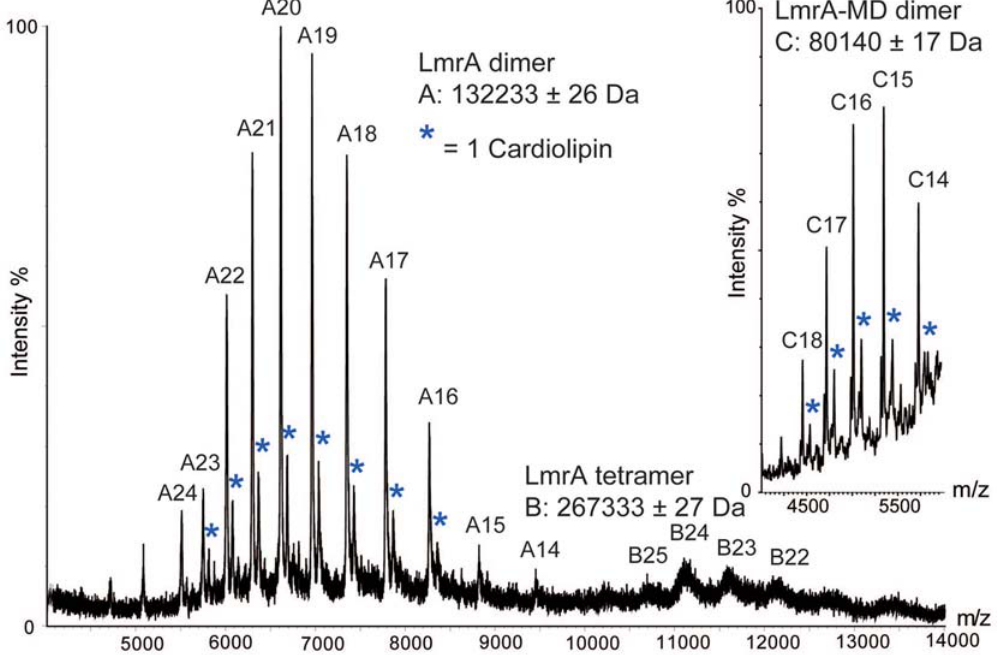
Figure 1. Mass spectra of purified LmrA and LmrA-MD showing predominant homodimer formation for both proteins. Peaks assigned to binding of one cardiolipin molecule are labelled (blue stars), and measured molecular masses are shown.